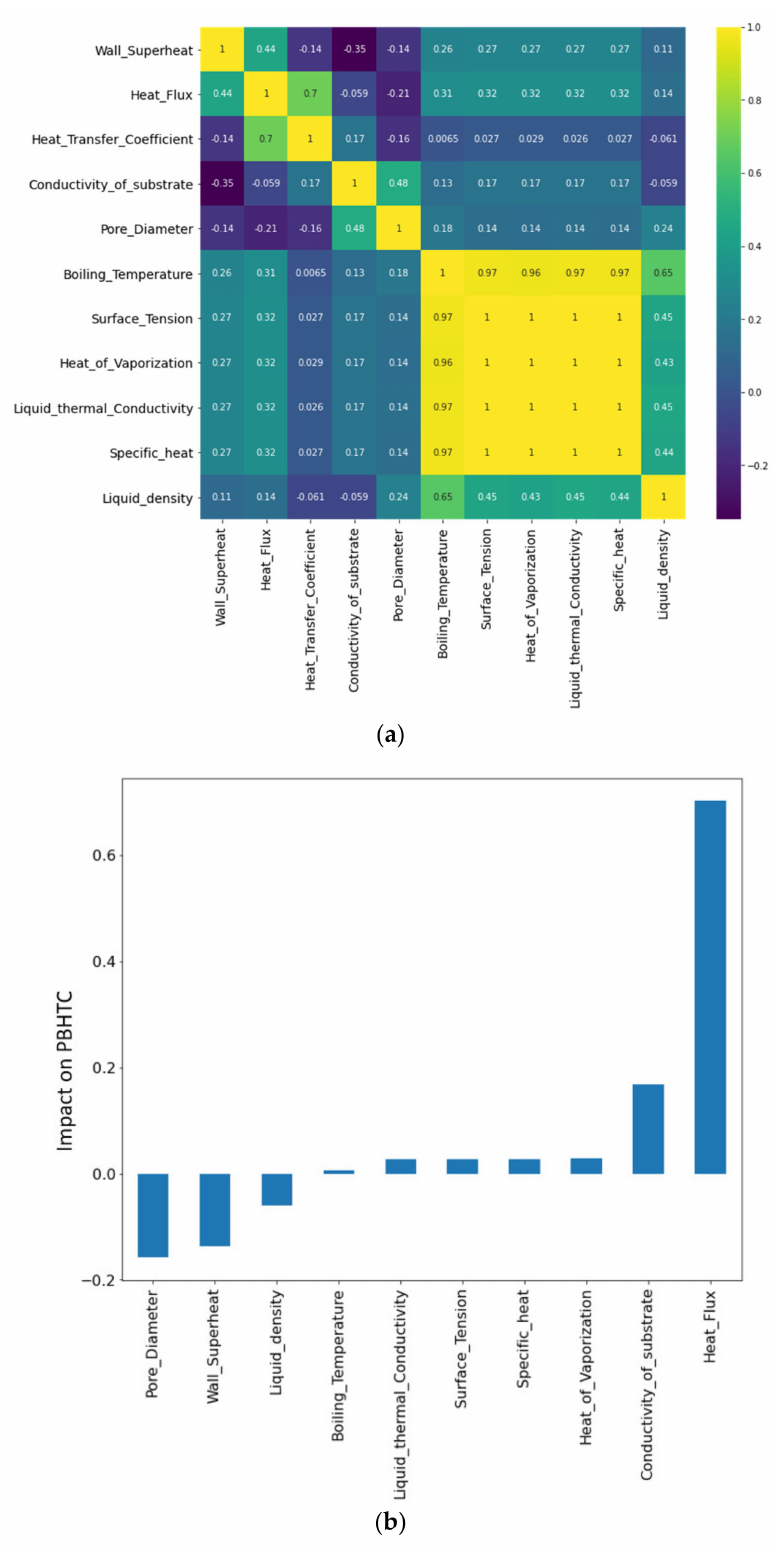
Figure 1. Features correlation ( a ) heat map and ( b ) correlation